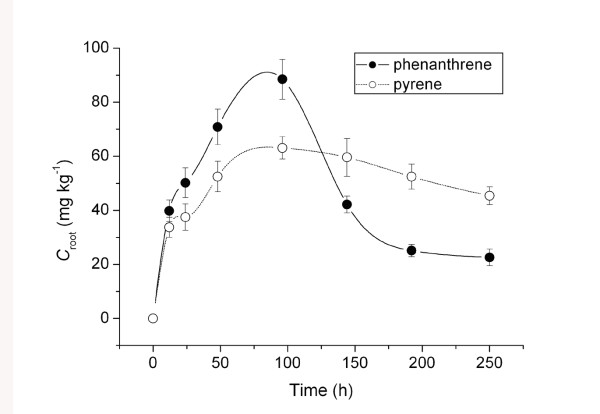
Concentrations of phenanthrene and pyrene in ryegrass roots as a function of uptake time. Croot means concentrations of phenanthrene and pyrene in ryegrass root.